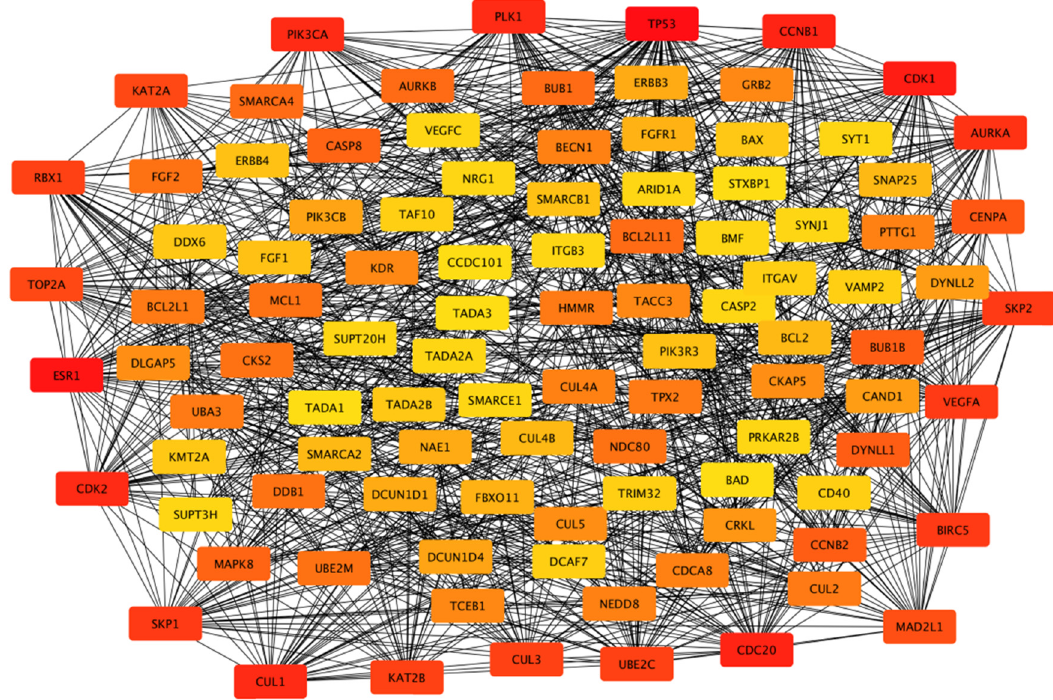
Figure 3: The PPI network associated with the 164 gene targets. Note: Box colors only represent relative comparison of connection counts of boxes in the network. Deeper red represents more